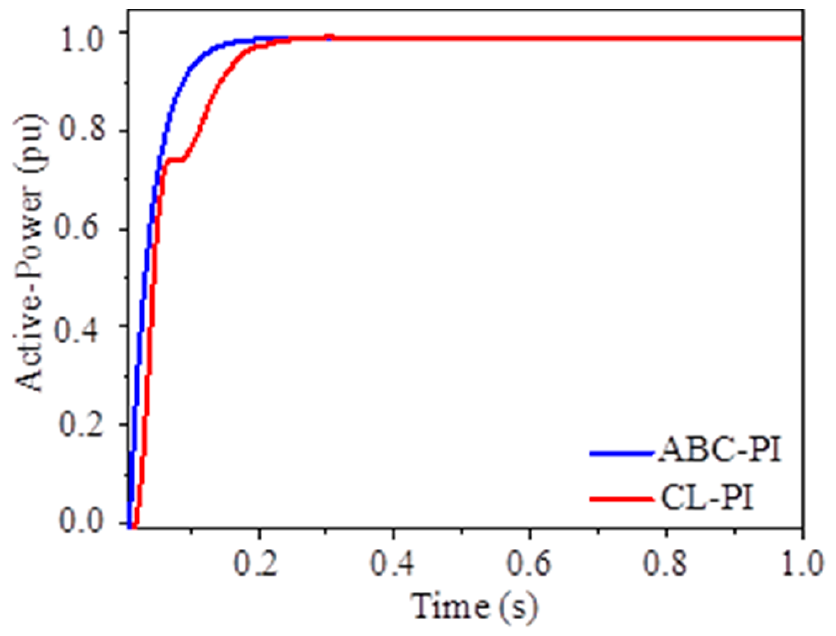
Figure 12. Active power step ‐ response for classical tuned PI and ABC ‐ PI.